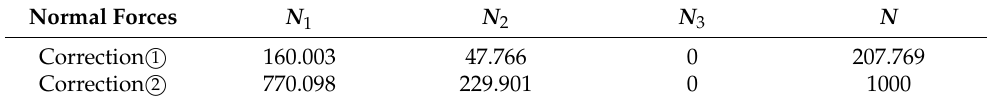
The corrected pressure curves are shown in Figure 12. The correction amplitude is large, and there is obvious deviation.